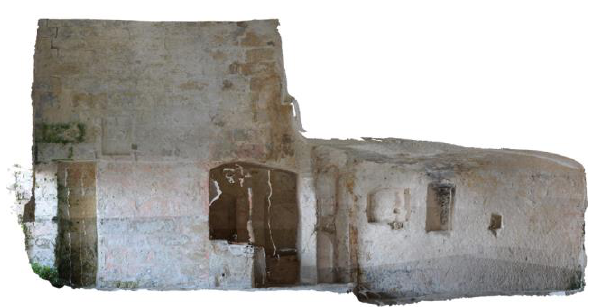
Figure 11. Orthophoto of the interior